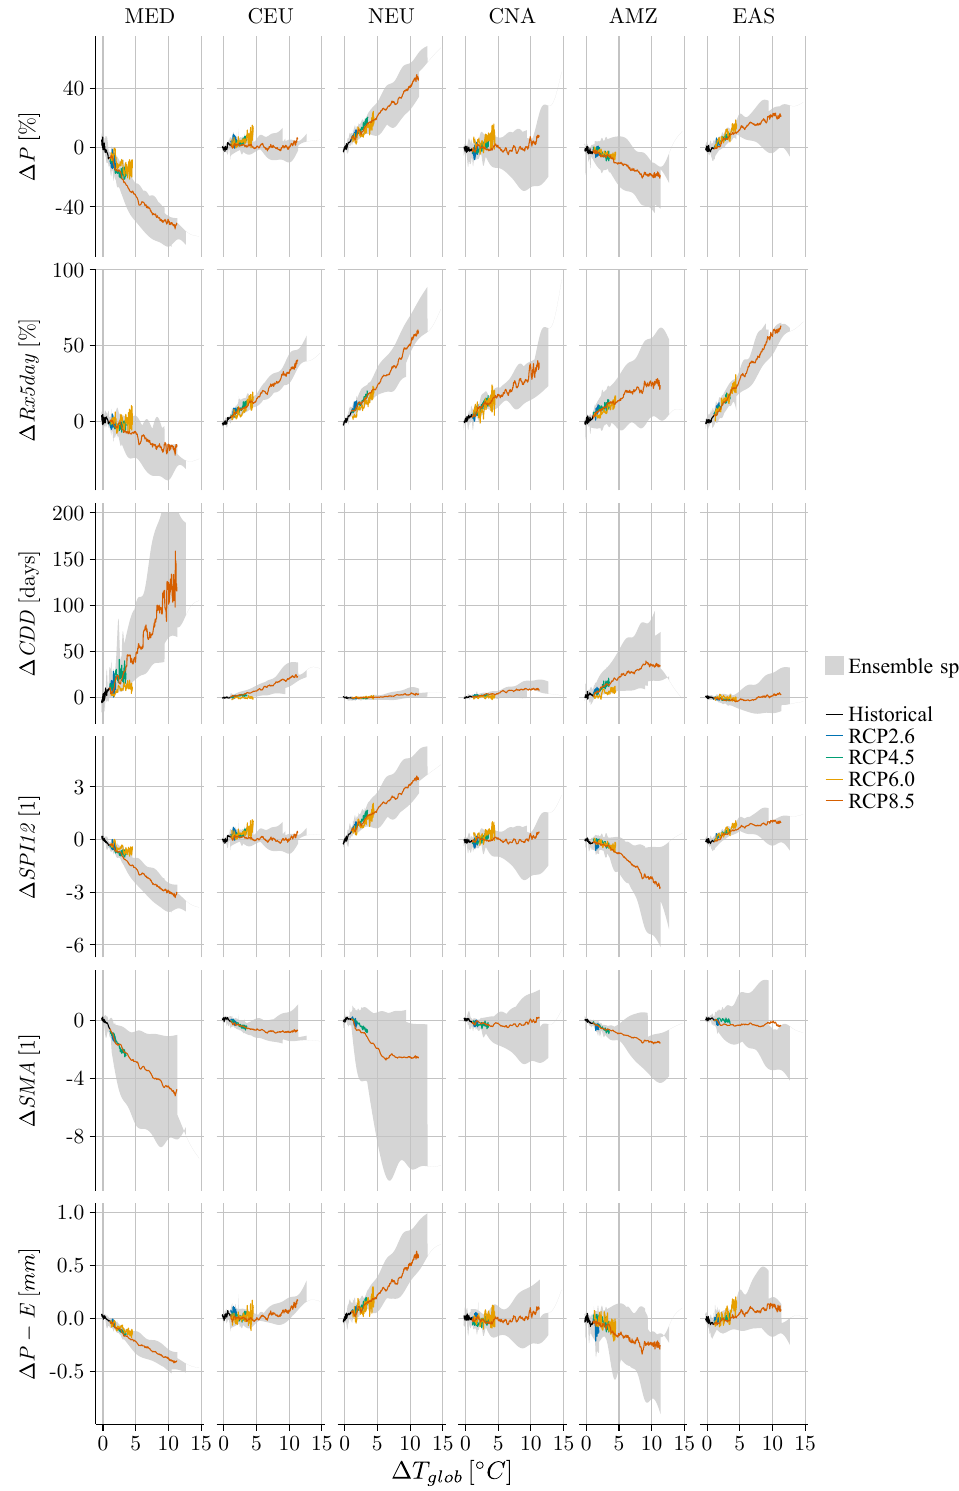
Figure 9. Like Fig. 4 but for the time period 1861–2299. Values for (cid:49) CDD > 200 days were cut off for readability.